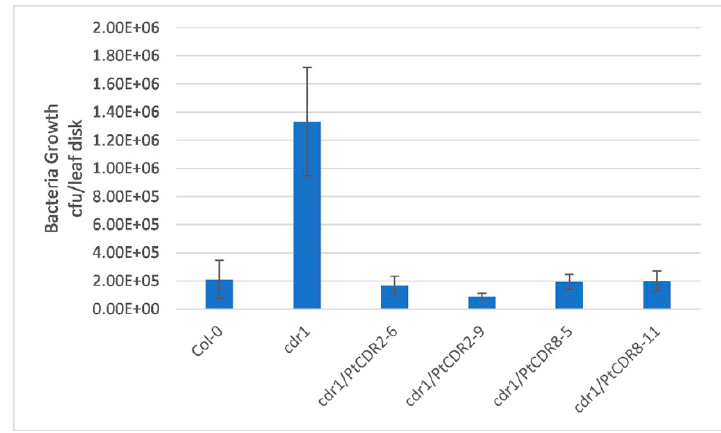
Figure 3. Bacteria growth assay. Twenty ‐ five ‐ day ‐ old Arabidopsis plants were inoculated with Pseudomonas syringae pv. tomato strain DC3000 ( Pst DC3000) expressing avrRpt2 by spraying a bacterial cell suspension. Six leaf disks from each plant were collected randomly at 3 DPI, and bacterial cells were extracted and plated out on a solid selective medium containing two antibiotics. Inoculated plants were wild ‐ type Arabidopsis (Col ‐ 0), cdr1 mutant (cdr1), and four transgenic cdr1 lines (cdr1/PtCDR2 ‐ 6, cdr1/PtCDR2 ‐ 9, cdr1/PtCDR8 ‐ 5, and cdr1/PtCDR8 ‐ 11)